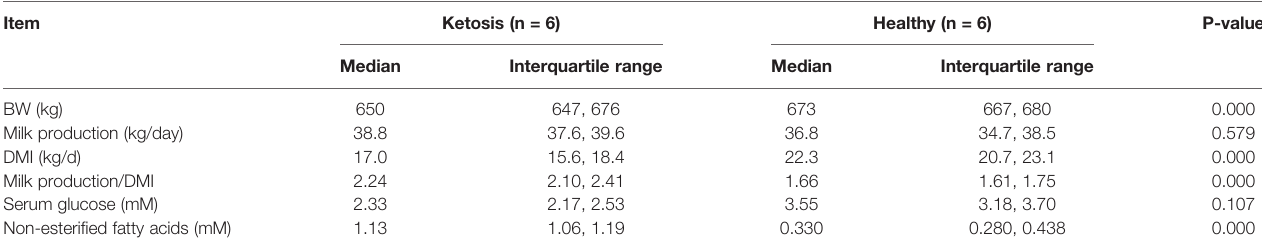
TABLE 2 | Basic performance and energy balance biomarkers in healthy cows and cows with ketosis.